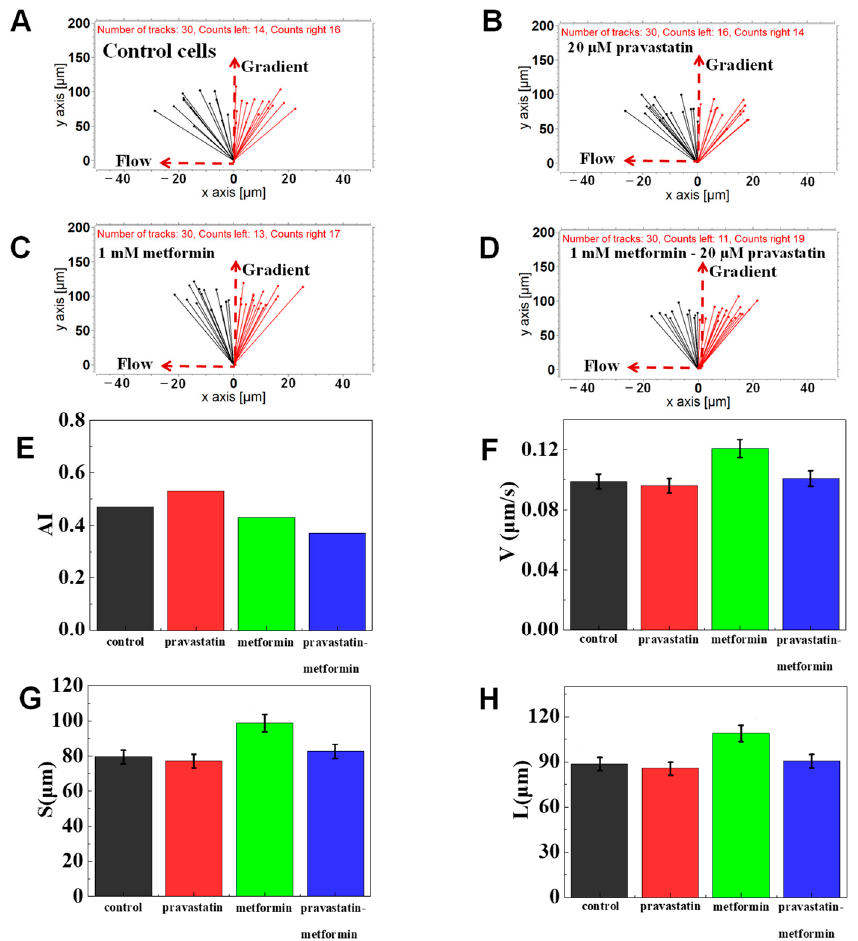
Figure 5. Chemotaxis of drugs-treated cells in 100 nM of fMLP chemoattractant. ( A ) The connecting line between the initial position and the end position of control cells. ( B ) The connecting line between the initial position and the end position of cells pretreated with 20 µ M pravastatin. ( C ) The connecting line between the initial position and the end position of the cells pretreated with 1 mM metformin. ( D ) The connecting line between the initial position and the end position of the cells pretreated with 1 mM metformin and 20 µ M pravastatin. ( E – H ) Comparison of quantitative cell migration parameters including drifting index (AI), cell velocity (V), the displacement along the gradient (S), and the whole movement distance